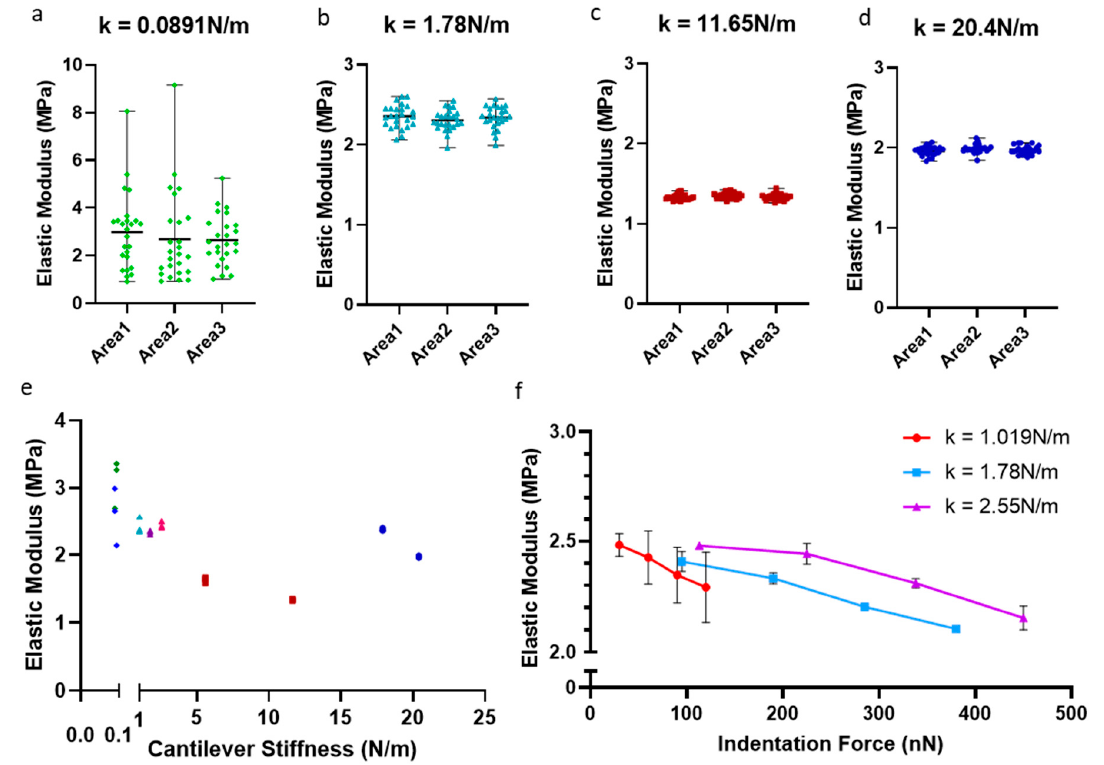
Figure 4. Effect of cantilever stiffness and indentation force on measured elastic modulus of PDMS gel, with a listed modulus of 2.5 MPa. Effects of cantilever stiffness and indentation force on measured elastic modulus of a PDMS gel with a listed modulus of 2.5 MPa. Areas were not the same between cantilevers, but all were in the central region of the PDMS sample. ( a – d ) Examples from one probe from each group with listed cantilever stiffnesses k = 0.06 (a, green diamond), 1 (( b ) light blue triangle), 8.9 (( c ) red square), and 16 N/m (( d ) navy dot). All indentations were performed with ramp size = 2 µm, ramp rate = 1 Hz, and indentation force 50% of maximum for each tip. ( e ) All probes were examined at 50% indentation limit; cantilever stiffness k plotted against stiffness result of PDMS gel. Probes with the same listed stiffness share a shape as in ( a – d ). There is no relationship between cantilever k and the result on PDMS. Probes from the k = 1 N/m group (triangles) are clustered, but others show little relationship with each other. Nominal stiffness 8.9N/m = red squares. Nominal stiffness 16N/m blue dots. All other probes have their own color. ( f ) Effects of indentation force by three tips with listed cantilever stiffness of k = 1 N/m. Actual cantilever stiffnesses are listed in the legend. All tips were comparable, but there was a significant decrease in modulus measured with increased indentation force (see Figure S3).